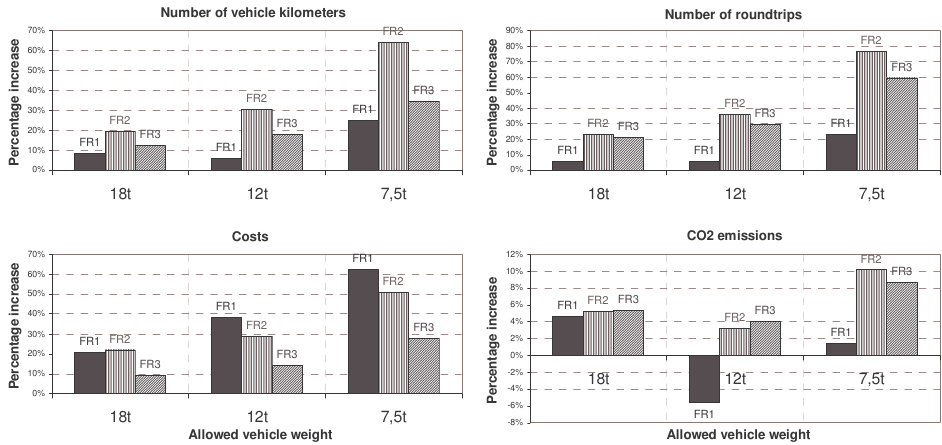
Figure 10. Values for all retailers and different weight